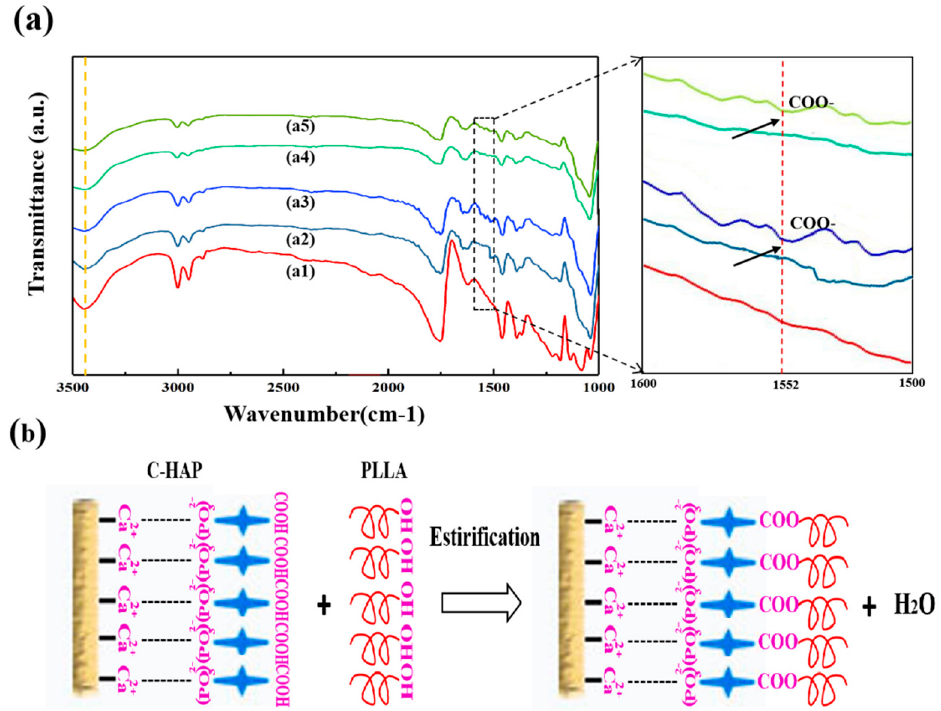
Figure 5. ( a ) FTIR spectra of different scaffolds (a1) PLLA scaffold, (a2) PLLA + 10% HAP scaffold, (a3) PLLA + 10% C-HAP scaffold, (a4) PLLA + 20% HAP scaffold, (a5) PLLA + 20% C-HAP scaffold, ( b ) The possible schematic of the possible interactions between C-HAP and PLLA matrix.